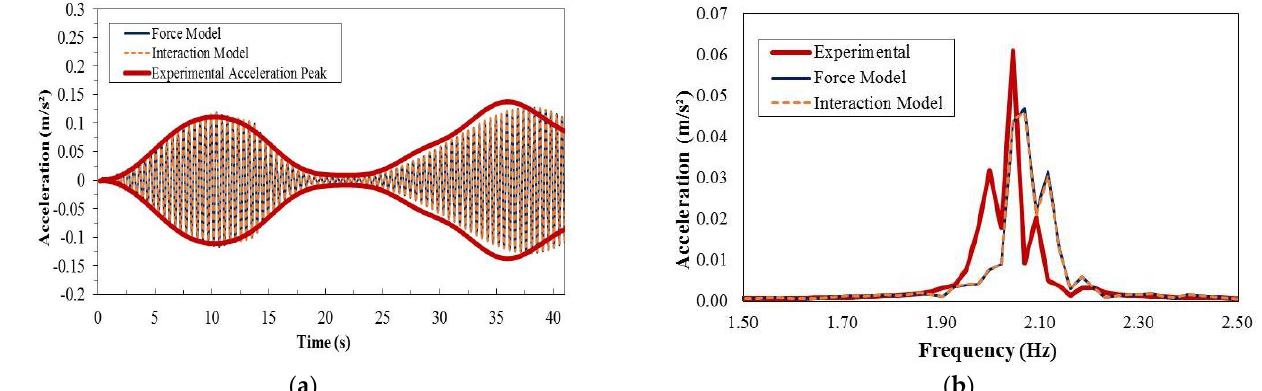
Figure 7. Second crossing of Test Subject 2: ( a ) time response; ( b ) spectrum.